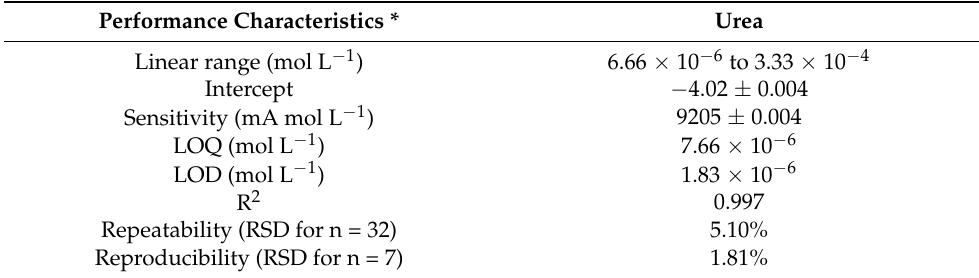
Table 4. Analytical features obtained for LSV urea determination.